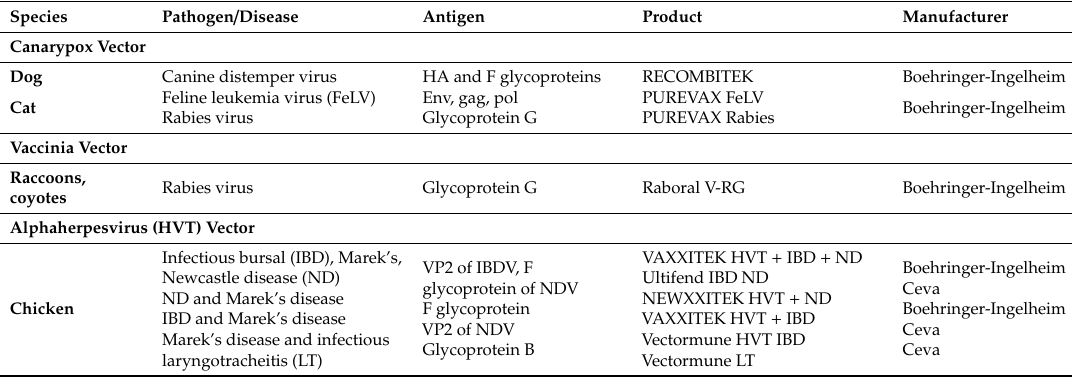
Table3. VeterinaryviralvectoredvaccineslicensedandavailableforcommercialuseintheUnitedStates.